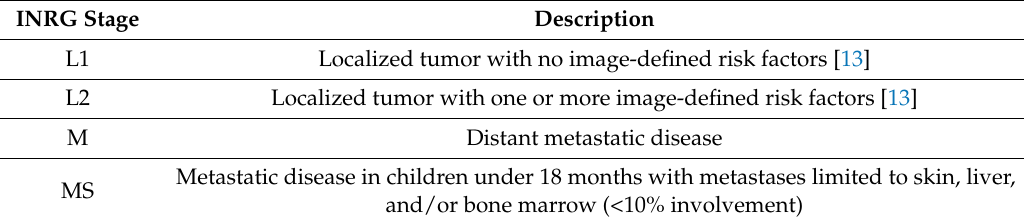
Table 2. International Neuroblastoma Risk Group Staging Sysem